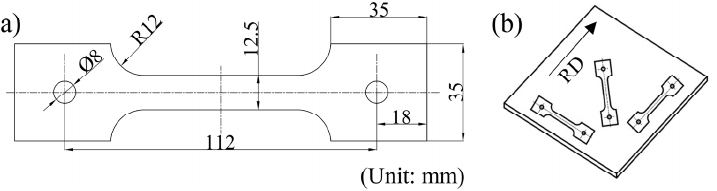
Figure 2. ( a ) The size of the hot uniaxial tensile specimen; ( b ) Cu tt ing scheme of the specimen.